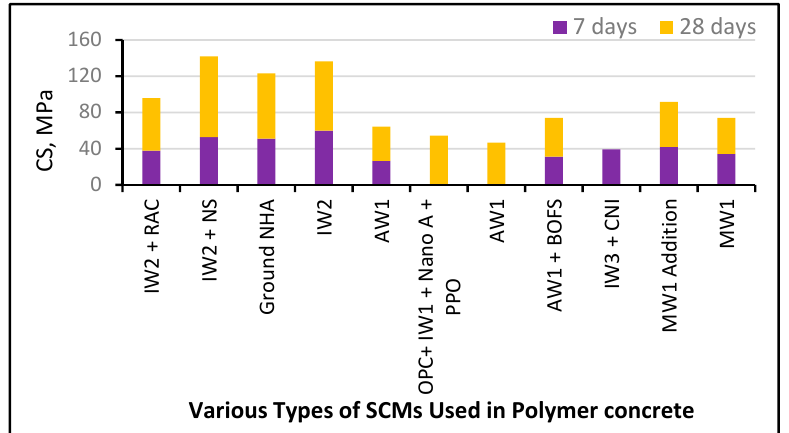
Figure 9. Compressive strength values for polymer concrete mixes for different SCMs.